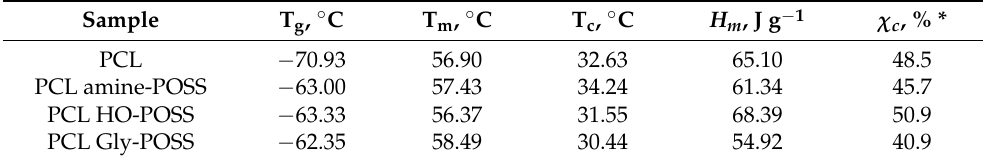
Table 1. DSC analysis of PCL POSS